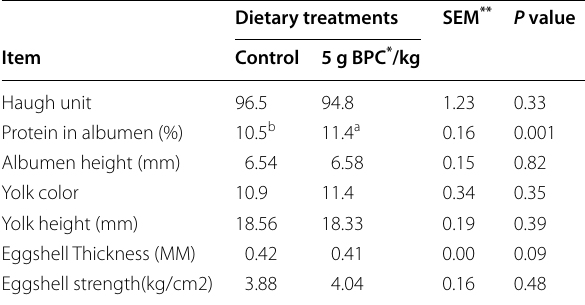
Table 5 The effects of dietary treatments on quality of the eggs